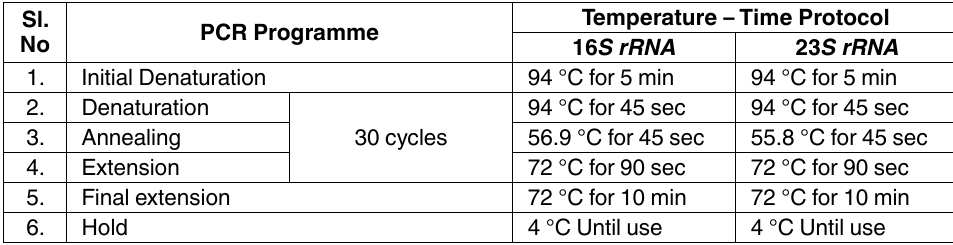
table 2. PCR protocol for the amplification for characterization of S.